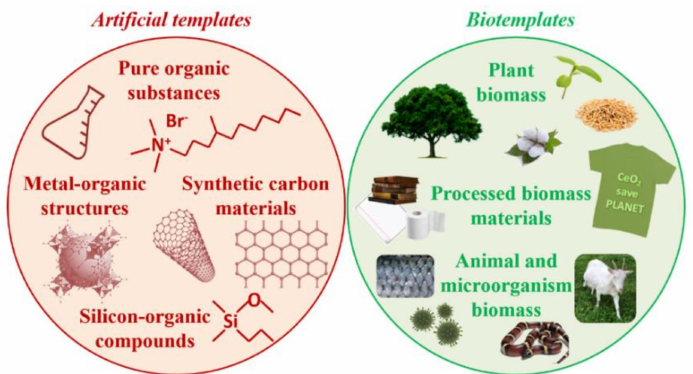
Figure 1. The search towards either artificial or bio-based templates to exert control over the growth of ceria has been very active. Reproduced from